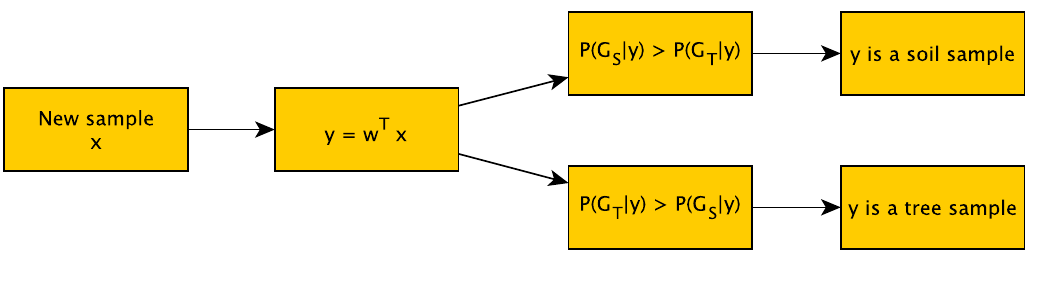
Figure 5. Proposed Fisher discriminant analysis (FDA) classifier